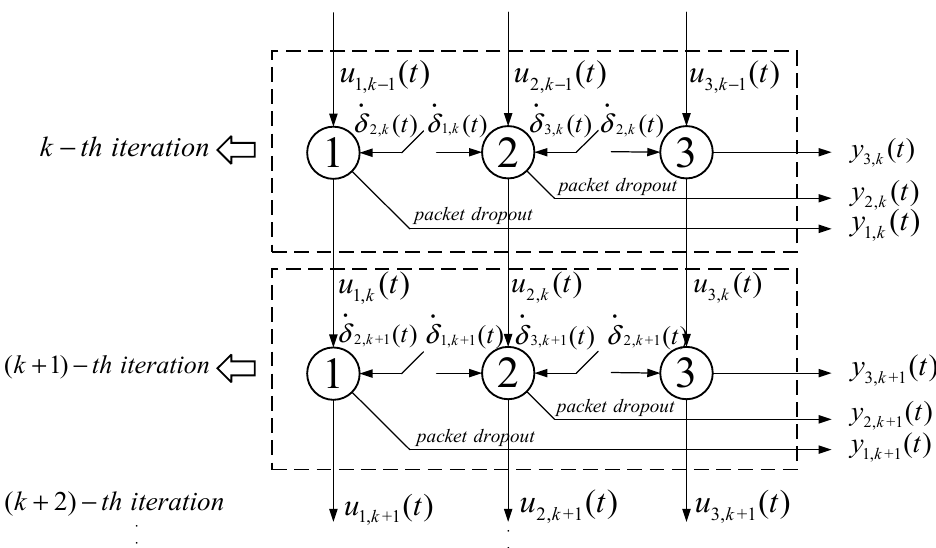
Figure 2. The structure of iterative learning control (ILC) for multi-agent systems with loss of multiple communication packets.